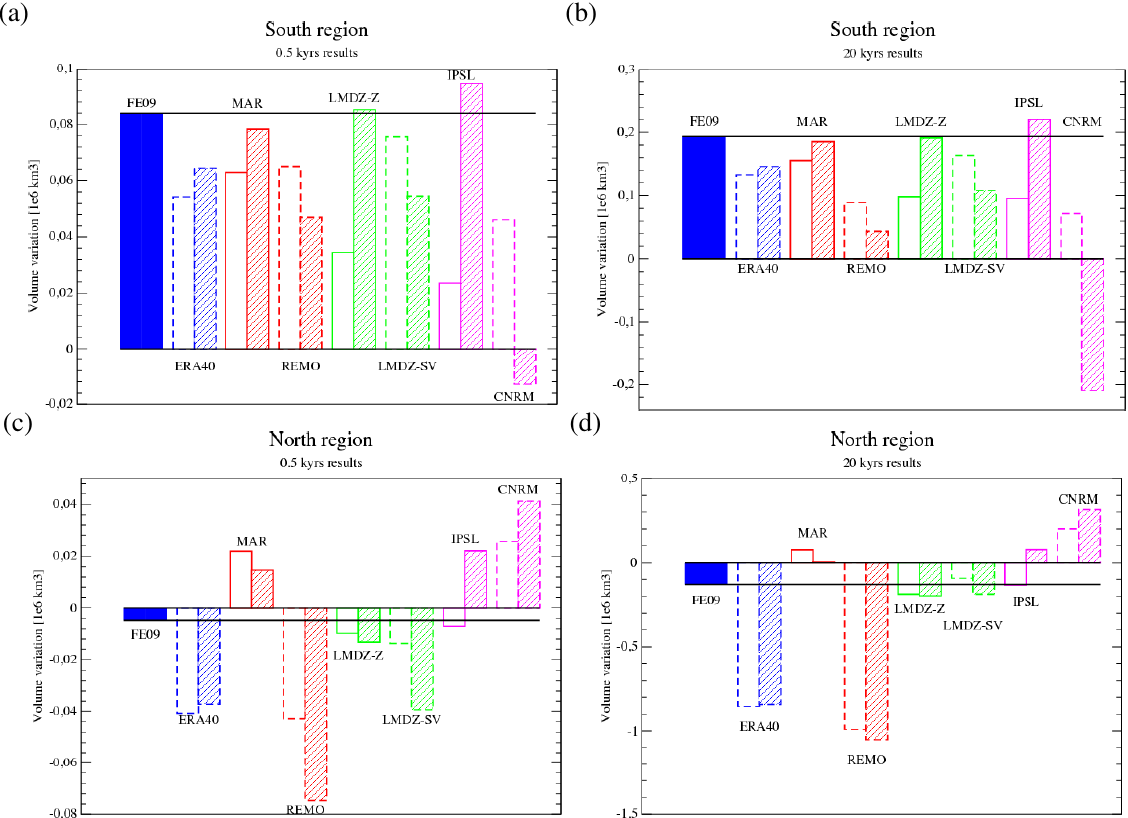
Fig. 9. Regional volume difference (simulated volume minus initial volume, being 1.10 and 0.46 10 6 km 3 for north and south, respectively) for each model run. Empty bars correspond to the standard volume difference ( dV i ) and hatched bars correspond to the volume difference computed with the precipitation in each model replaced by the Ettema et al. (2009) precipitation map ( dV 0 ). The first solid bar is the simulated reference volume difference ( dV 0 , FE09). The upper panel corresponds to the south region (latitudes lower than 68 ◦ N) at 0.5 kyr ( a ) and 20 kyrs ( b ), and the lower panel corresponds to the north region (latitudes greater than 75 ◦ N) at 0.5 kyr ( c ) and 20 kyrs ( d ).